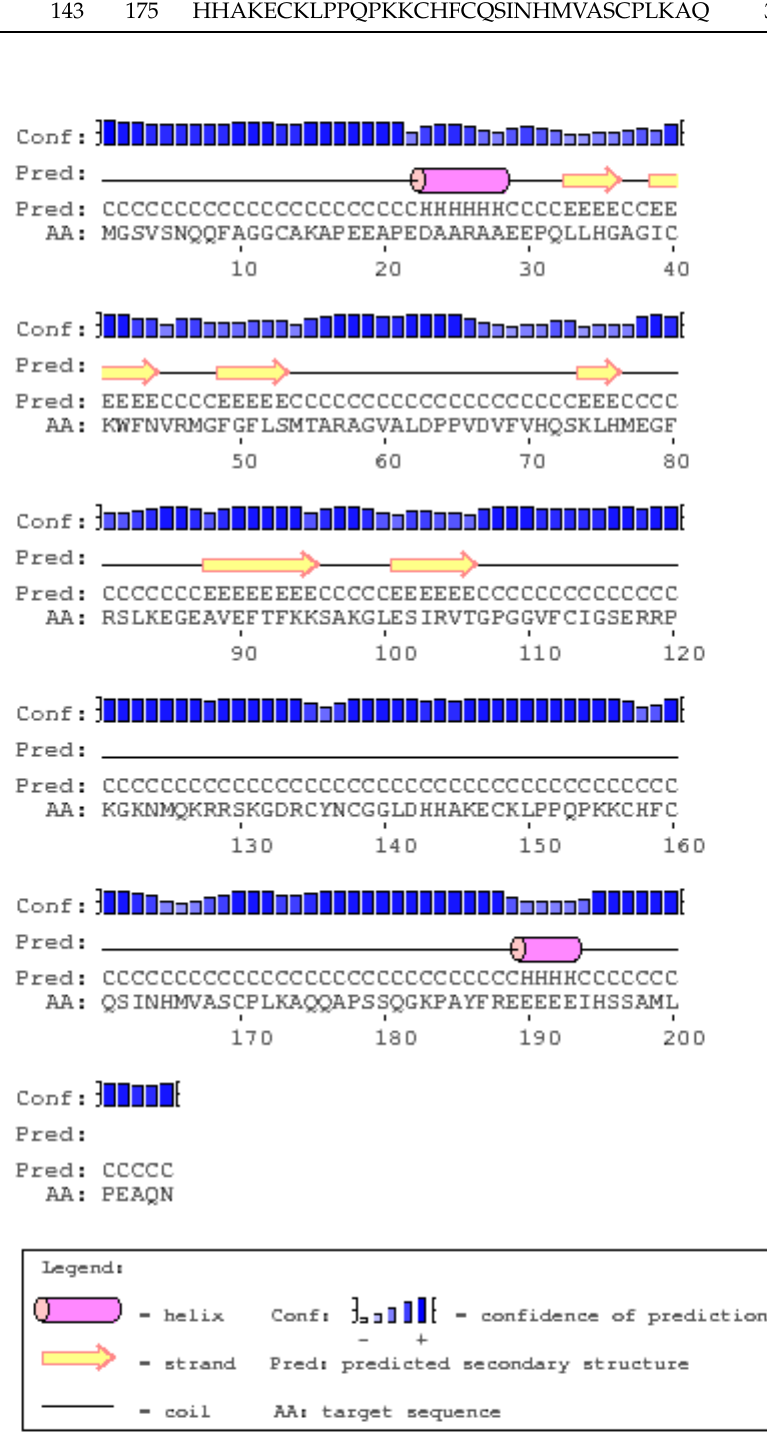
Figure 7. The secondary structure of the cLin-28